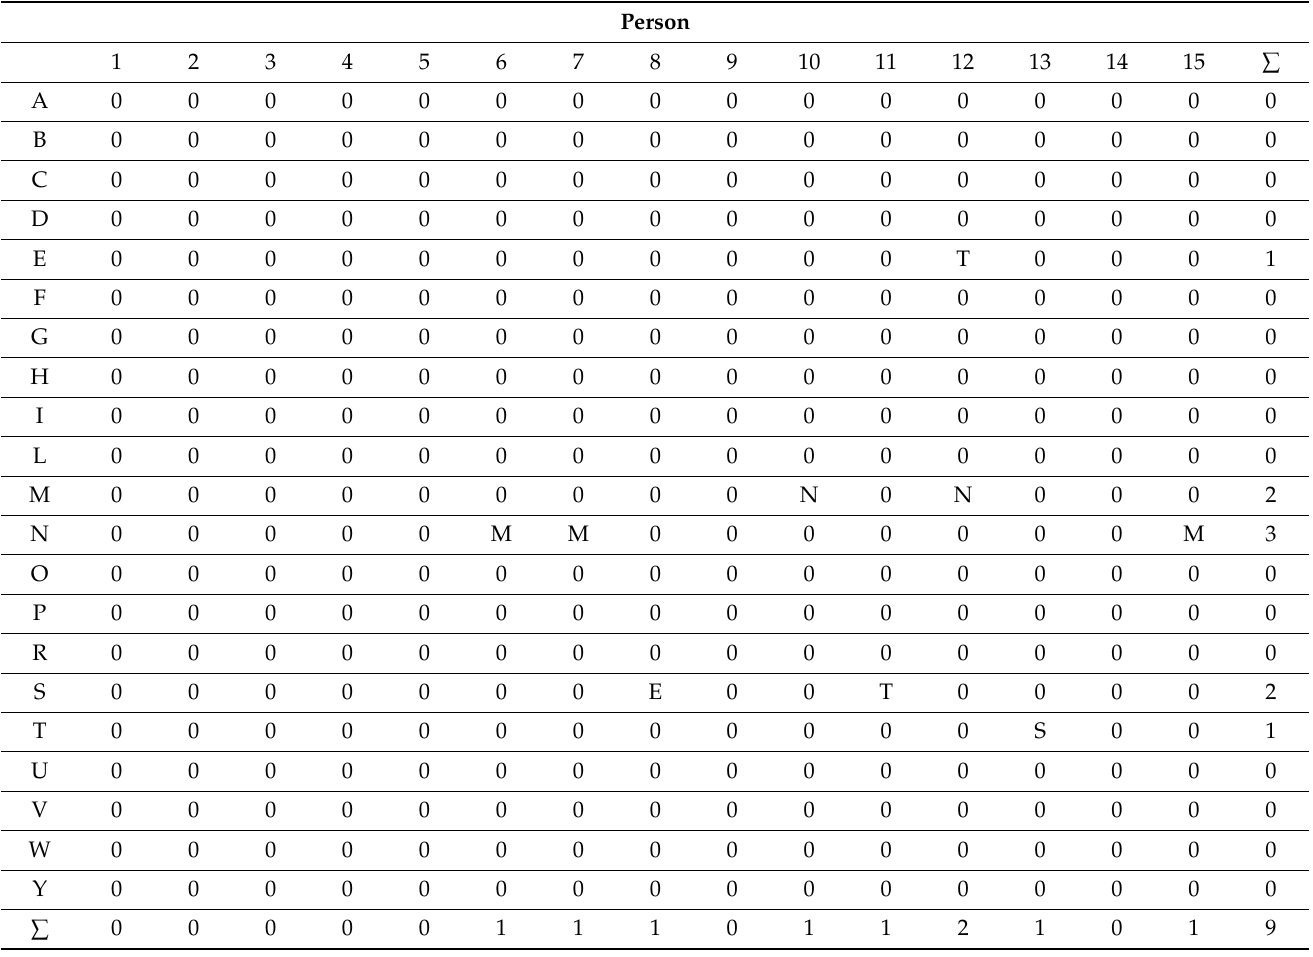
Table 4. Numbers of false negatives (FN) by letter and by person, for the confusion matrix of spherical features in Figure 6. Rows show the test letters, and columns show the test signers. For instance, Table(E,12) = T means that for the letter E and signer 12, a false negative was produced (where E was confused with T). The last column ∑ shows the total number of false negatives by letter, and the last row ∑ shows the total number of false negatives generated by each signer.